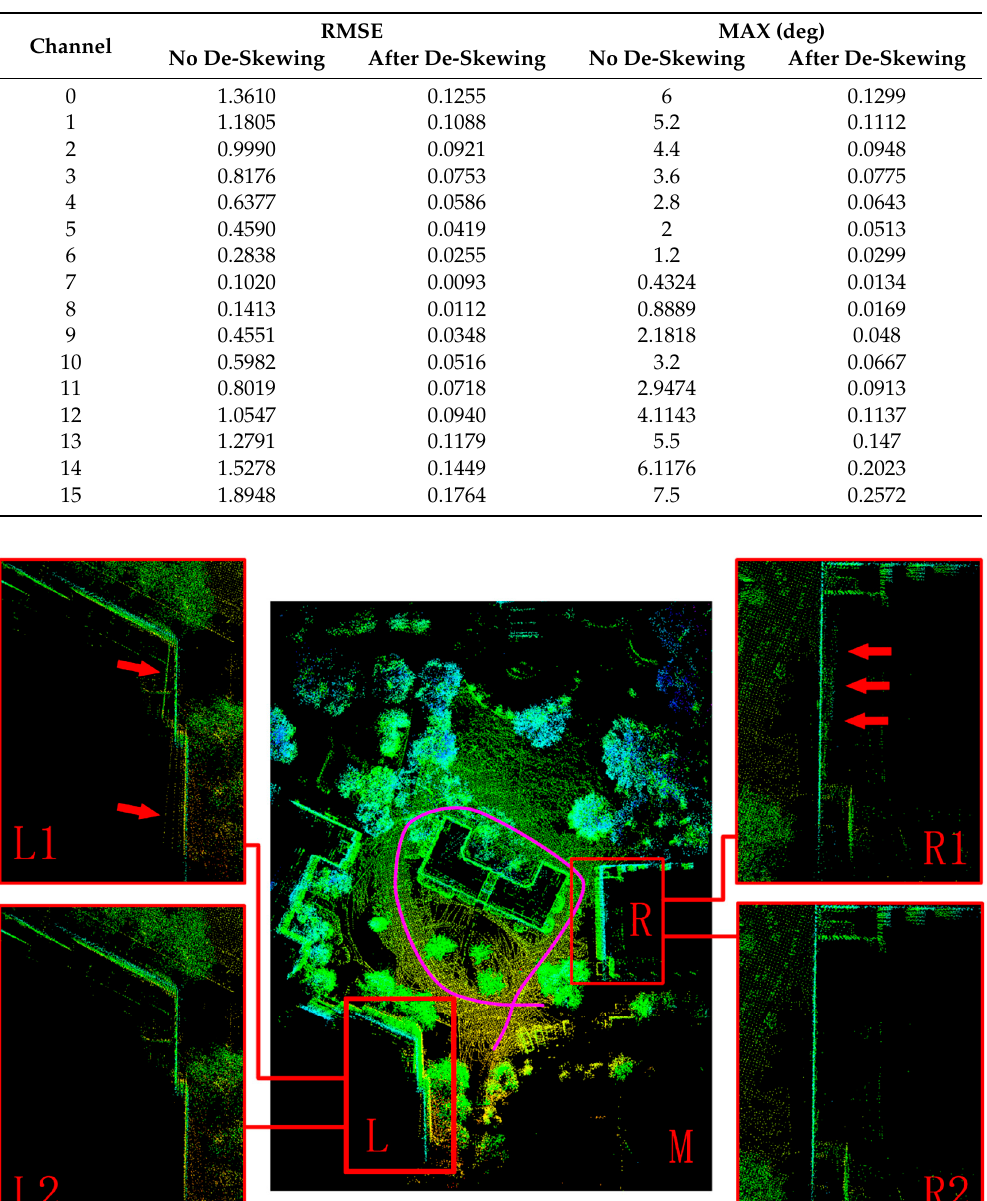
Table 4. Channel accuracy in the outdoor experiment.